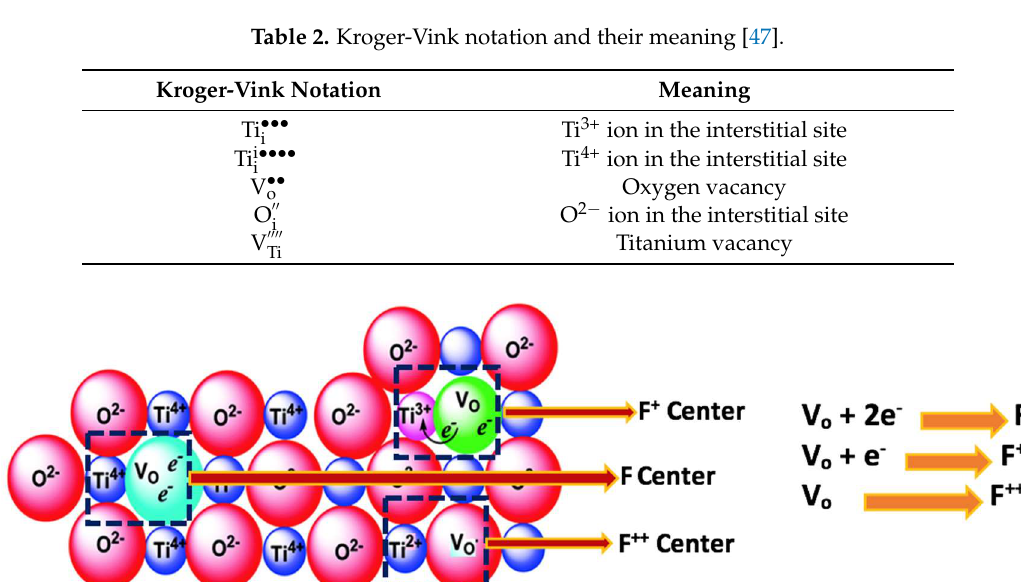
Figure 2. Schematic illustration and description of F center formation in Titania. Reproduced from